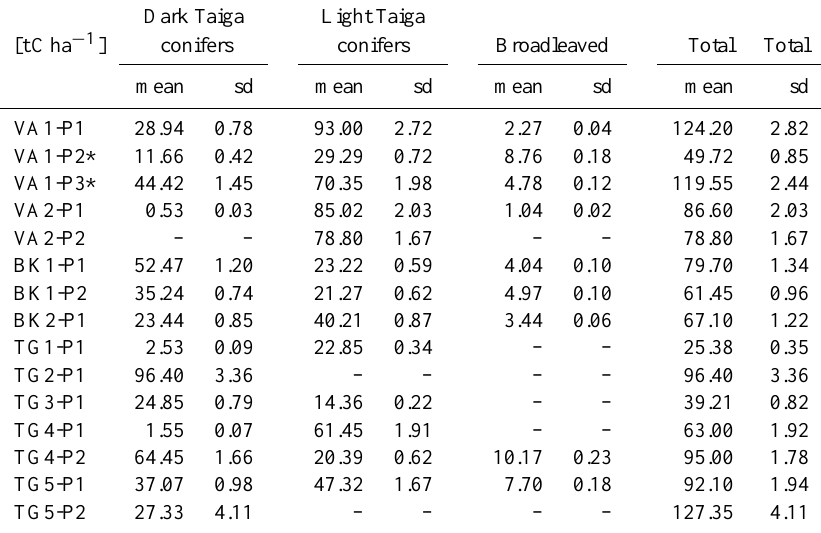
Table 4. Biomass carbon stocks including roots [tCha − 1 ] in the investigated plots. Dark taiga conifers include Picea obovata , Abies sibirica , and Pinus sibirica , light-taiga conifers include Larix sp. and Pinus sylvestris (see *); broadleaved trees include Betula sp. , Populus tremula , and Duschekia fruticosa . sd=standard deviation of biomass prediction.